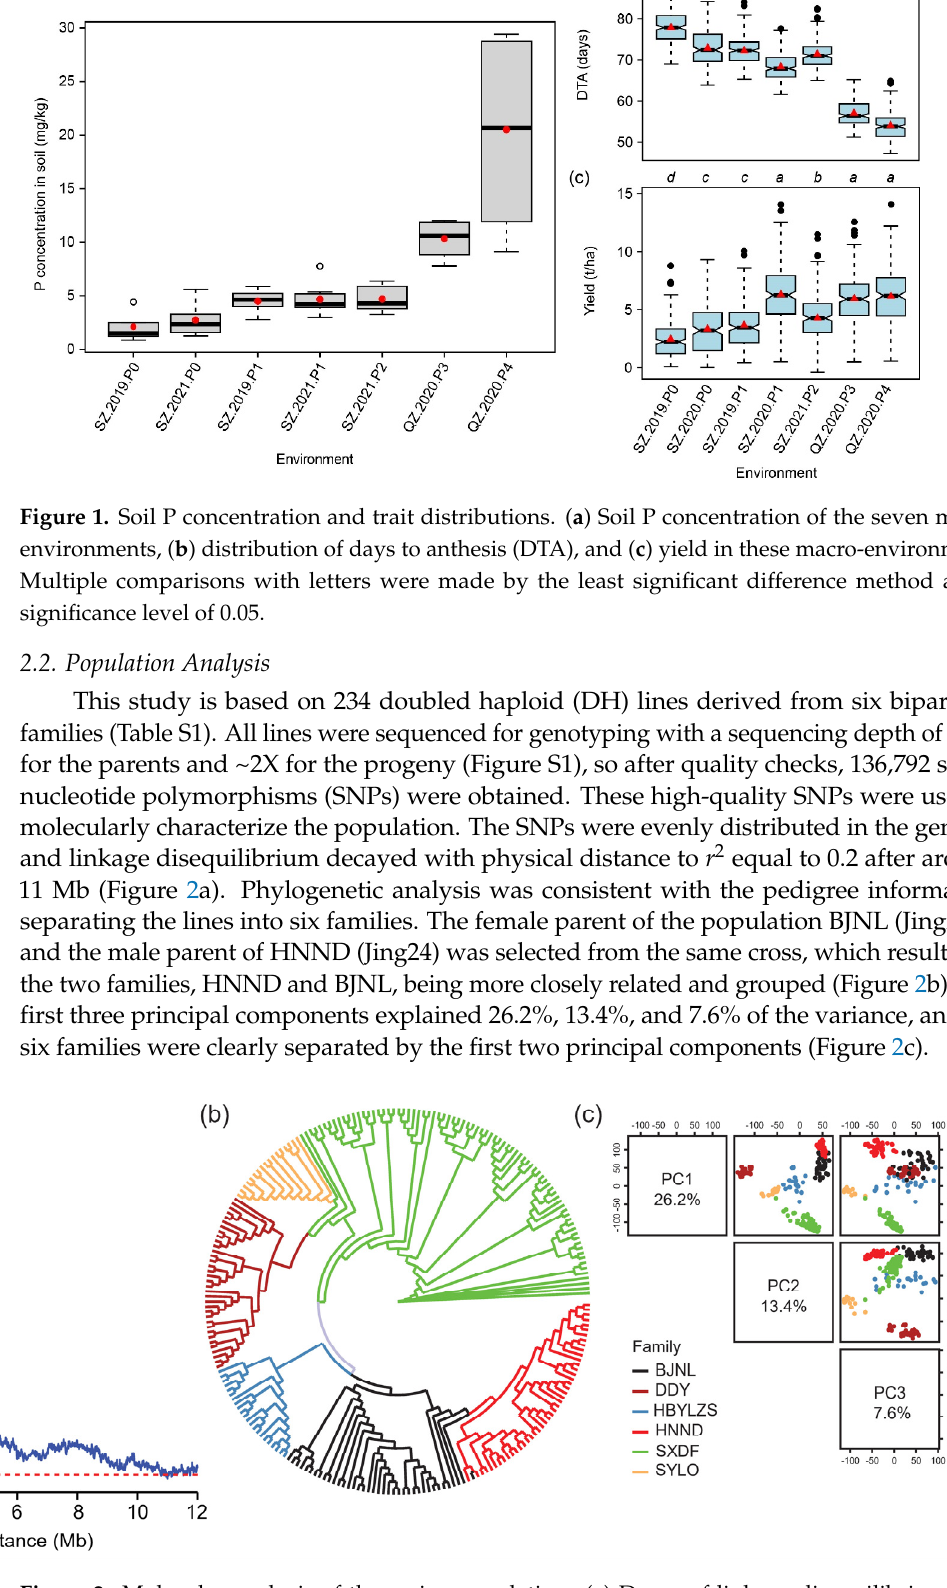
Figure 2. Molecular analysis of the maize population. ( a ) Decay of linkage disequilibrium with physical distance. ( b ) Neighbor-joining tree of the 234 doubled haploid lines from six families and ( c ) principal component analysis plots of the first three main components.